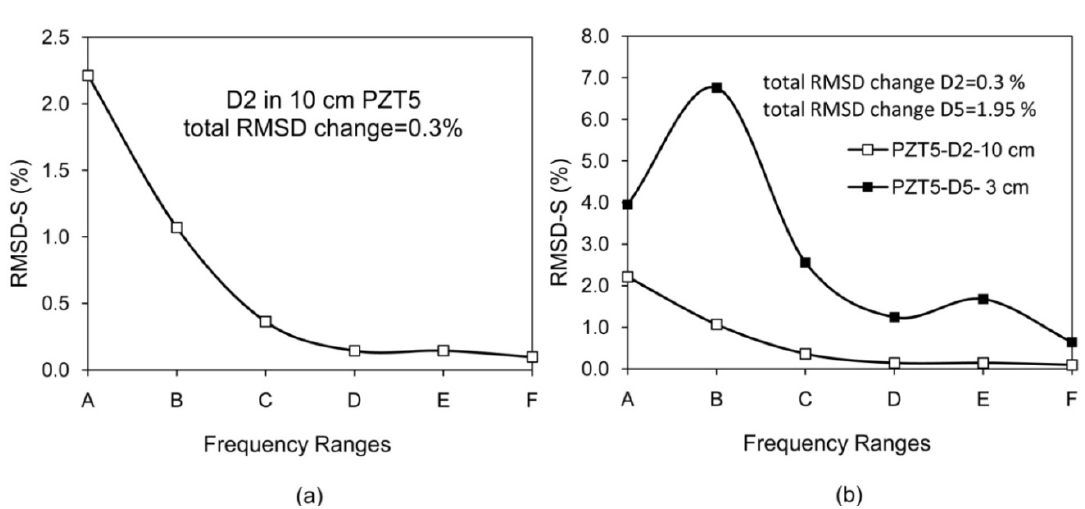
Figure 14. Possible issues of using RMSD as single value instead of RMSD-S, (a) Damage occurred far away from PZT (b) Similar damage occurred at two different distances from PZT.